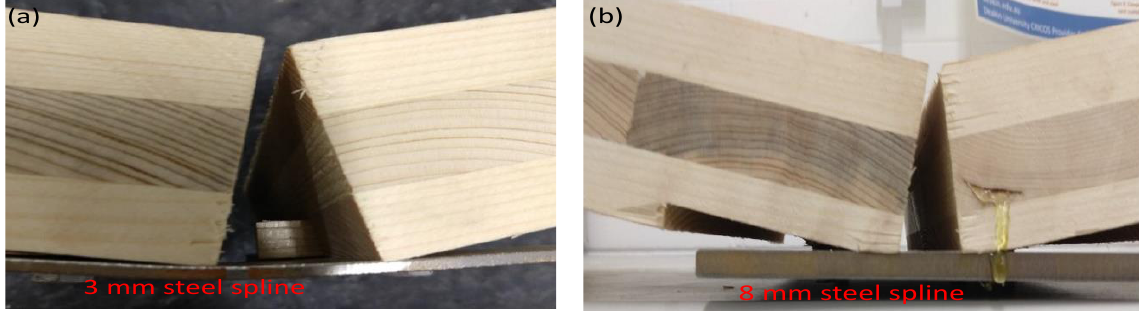
Figure 9. Failure modes associated with ( a ) 3 mm- and ( b ) 8 mm-thick steel spline connections.